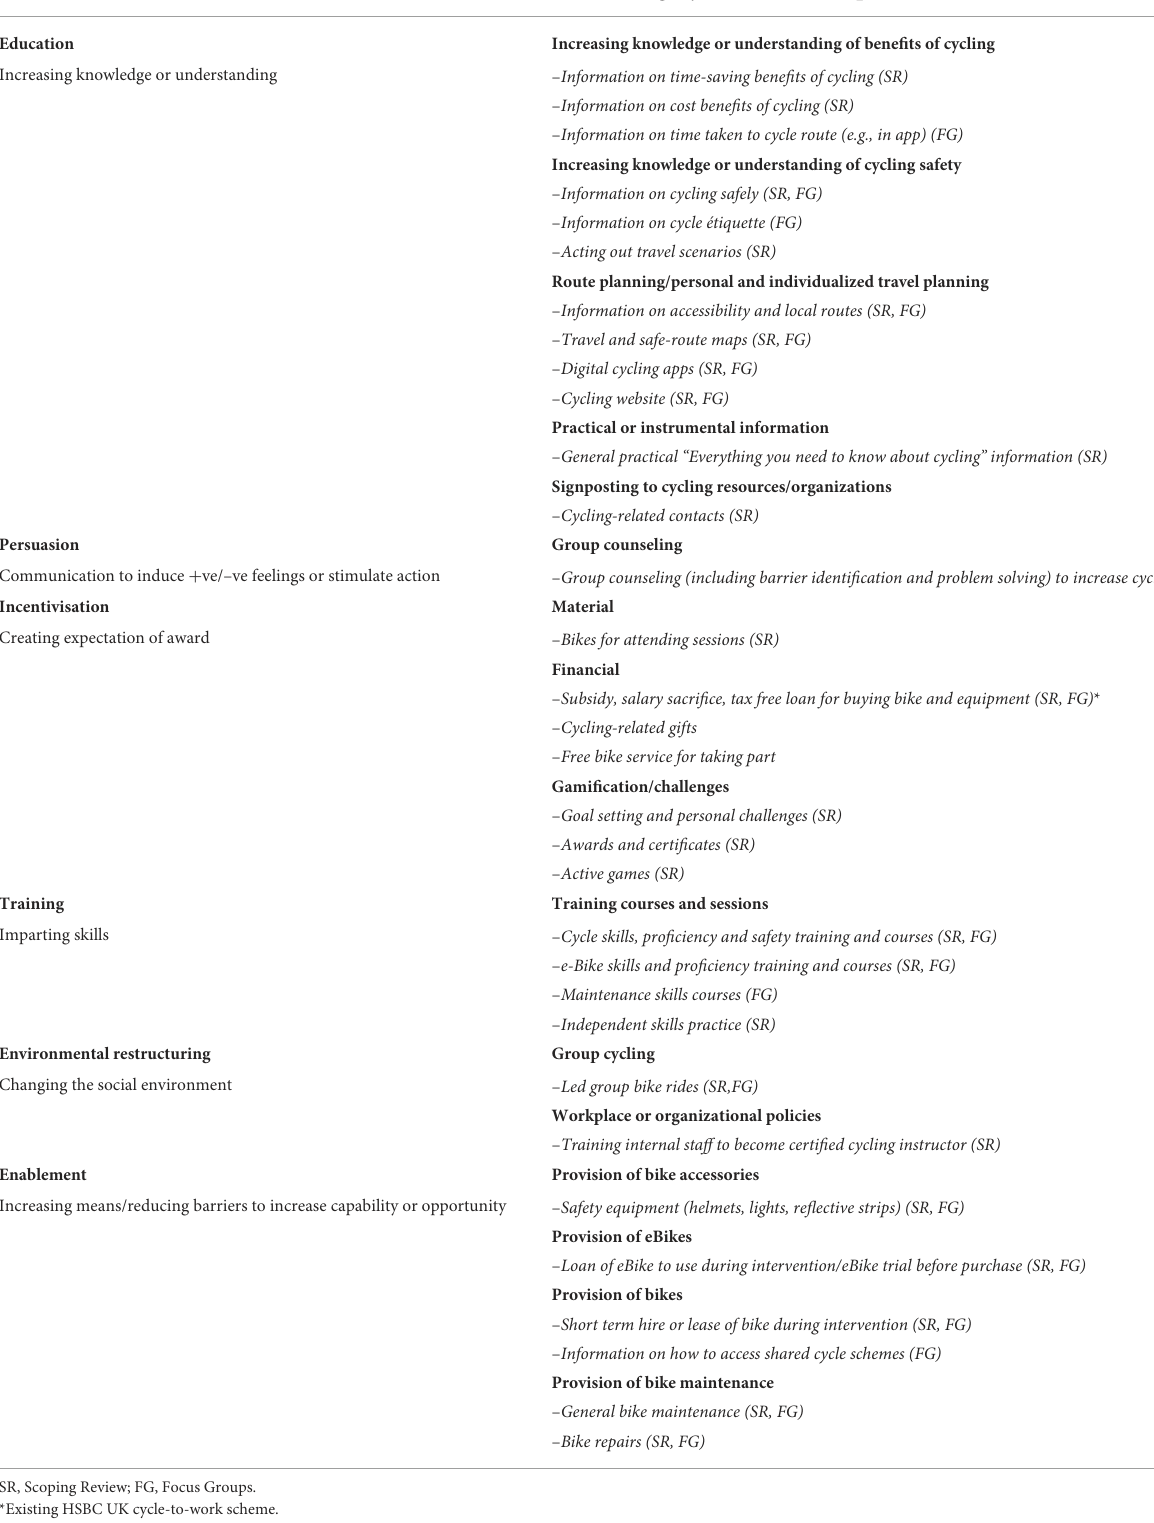
TABLE 4 Cycle Nation Program intervention core components identified following theoretical mapping and manager